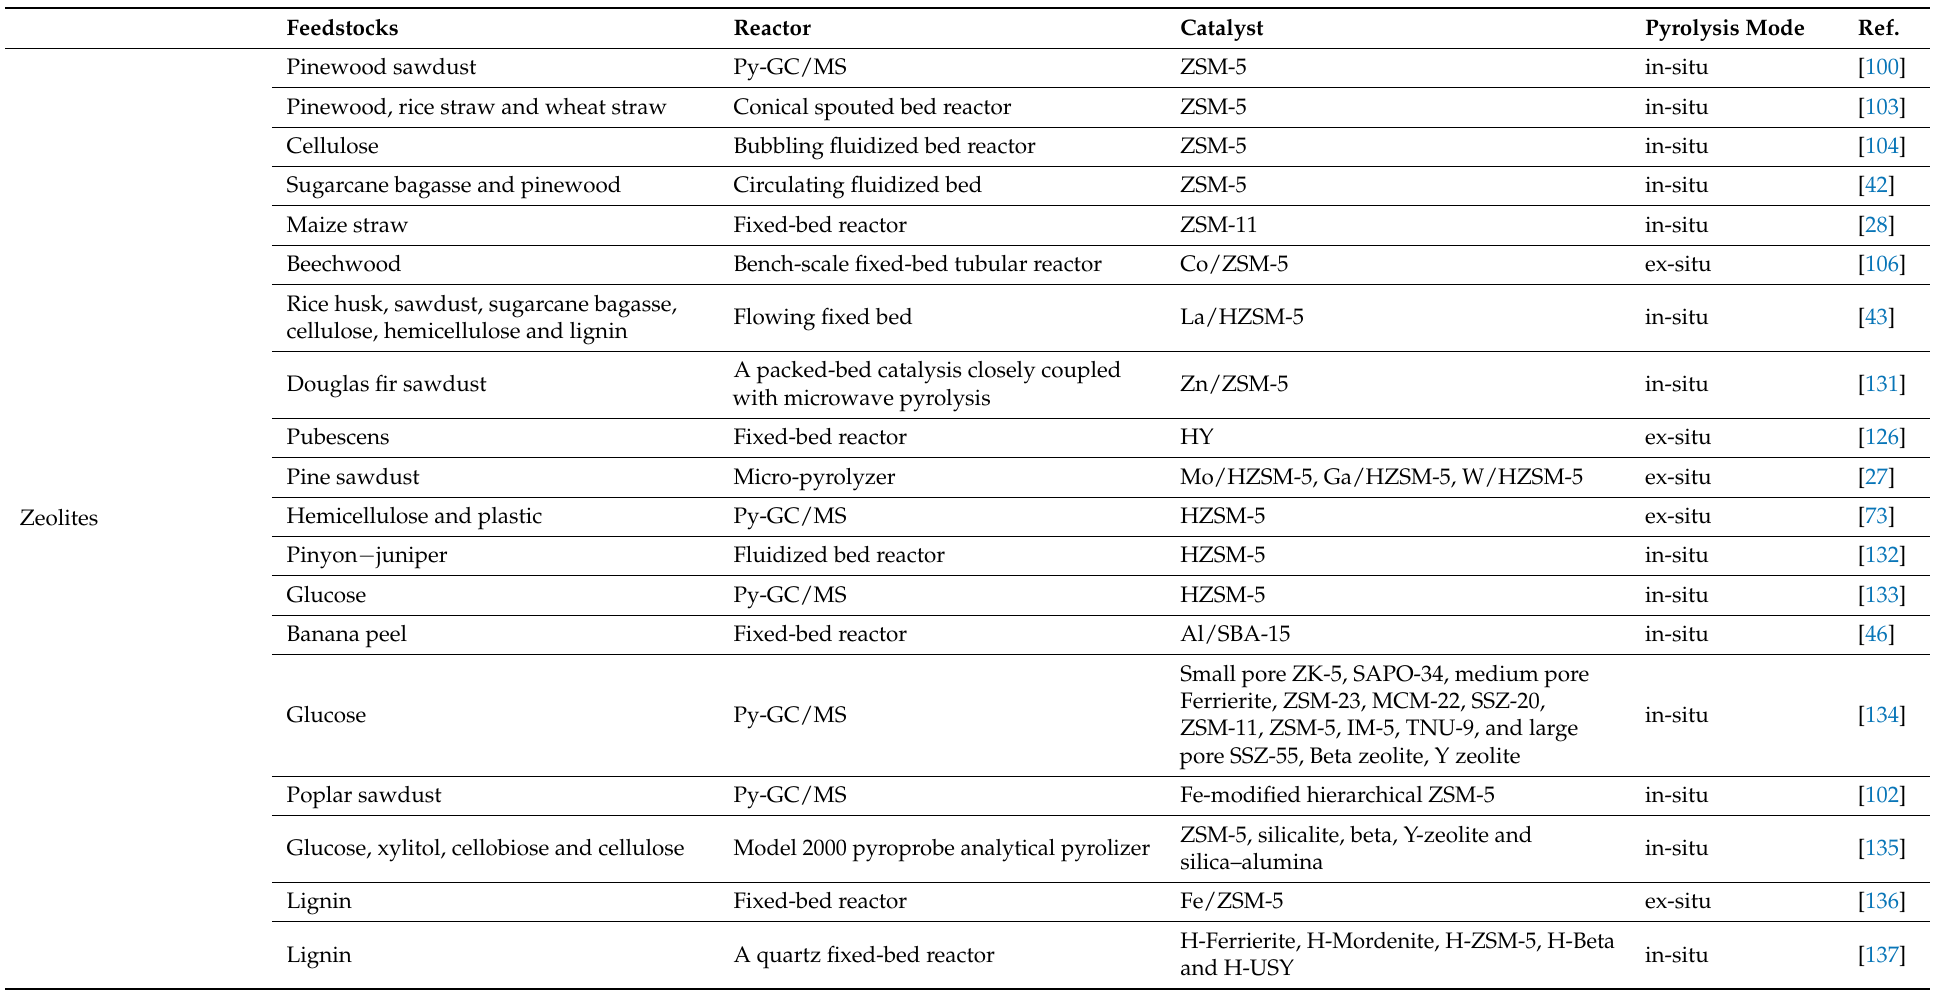
Table 5. The zeolites used in biomass catalytic